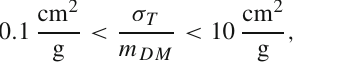
be achieved for light X μ with its mass e.g. m X ∼ O ( 1 MeV )